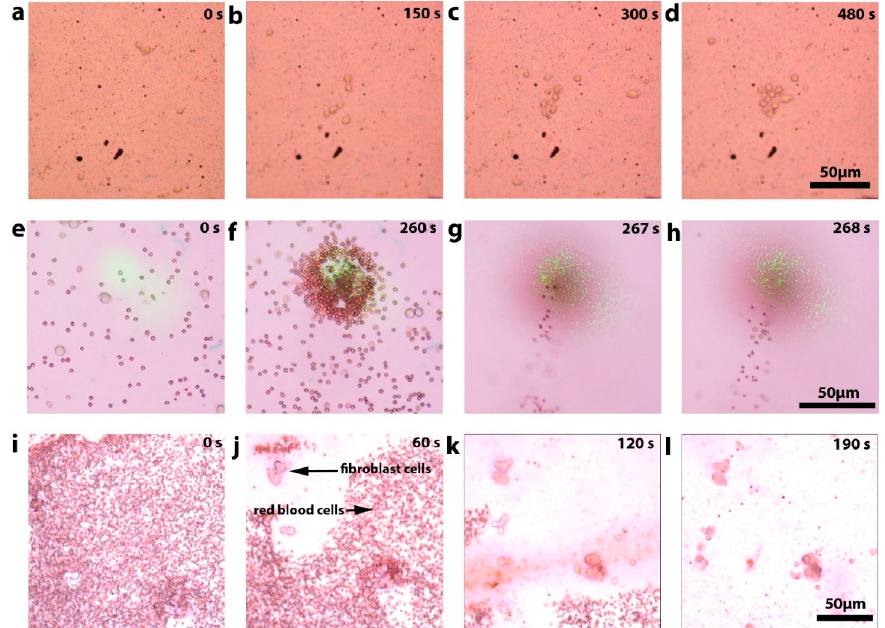
Figure 3. Experimental demonstration of several opto-fluidic manipulation regimes. ( a – d ) Trapping of fibroblast cells during 480 second period. ( e – h ) Trapping of heavy fibroblast cells simultaneously with the projection of lighter red blood cells. ( e , f ) Microscope imaging plane of the substrate, ( g , h ) imaging above the substrate demonstrates stream of red blood cells being levitated. ( i – l ) Targeted “pressure washing” removing light red blood cells from the surface leaving in place heavy fibroblast cells. Optical fiber scans under the whole portion of the substrate visible in the field of view selectively removing one type of the cells from the surface.